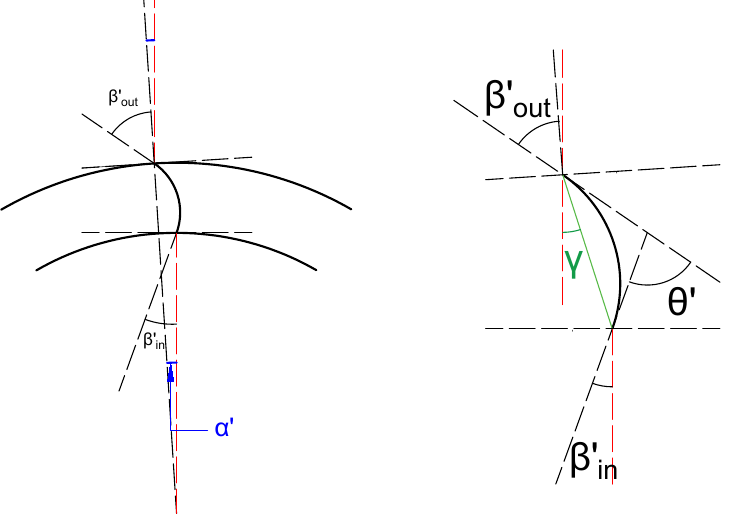
Figure 5. The main angles of the aerodynamic